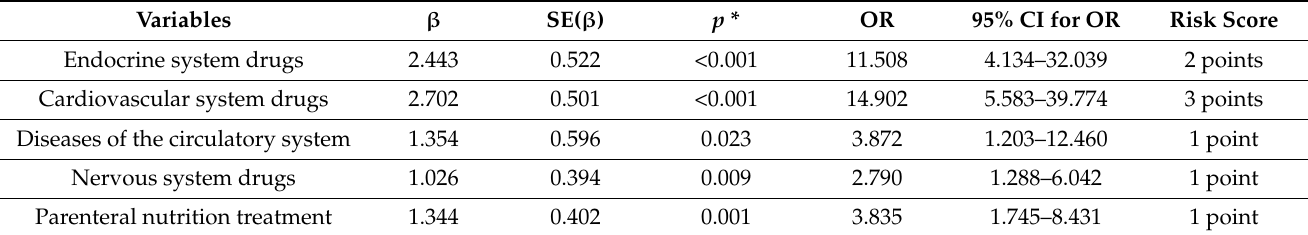
Table 3. Regression analysis of the variables used to predict the presence of